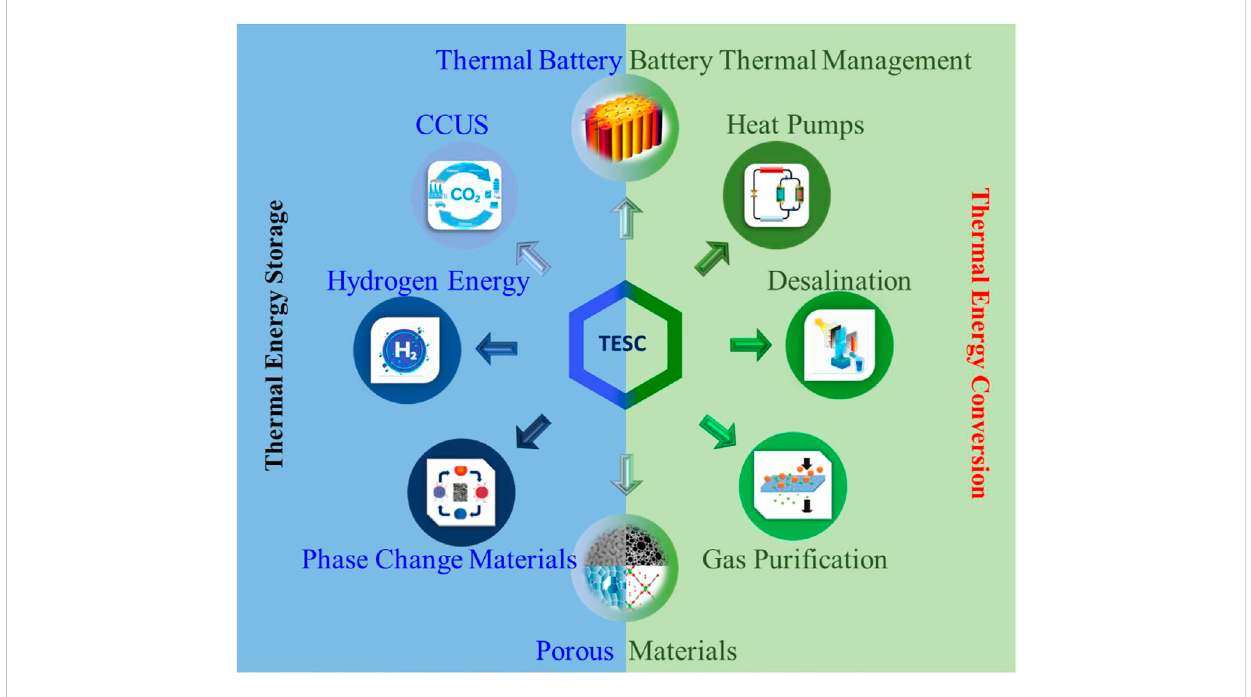
FIGURE 1 Promising research topics in thermal energy conversion and storage fi